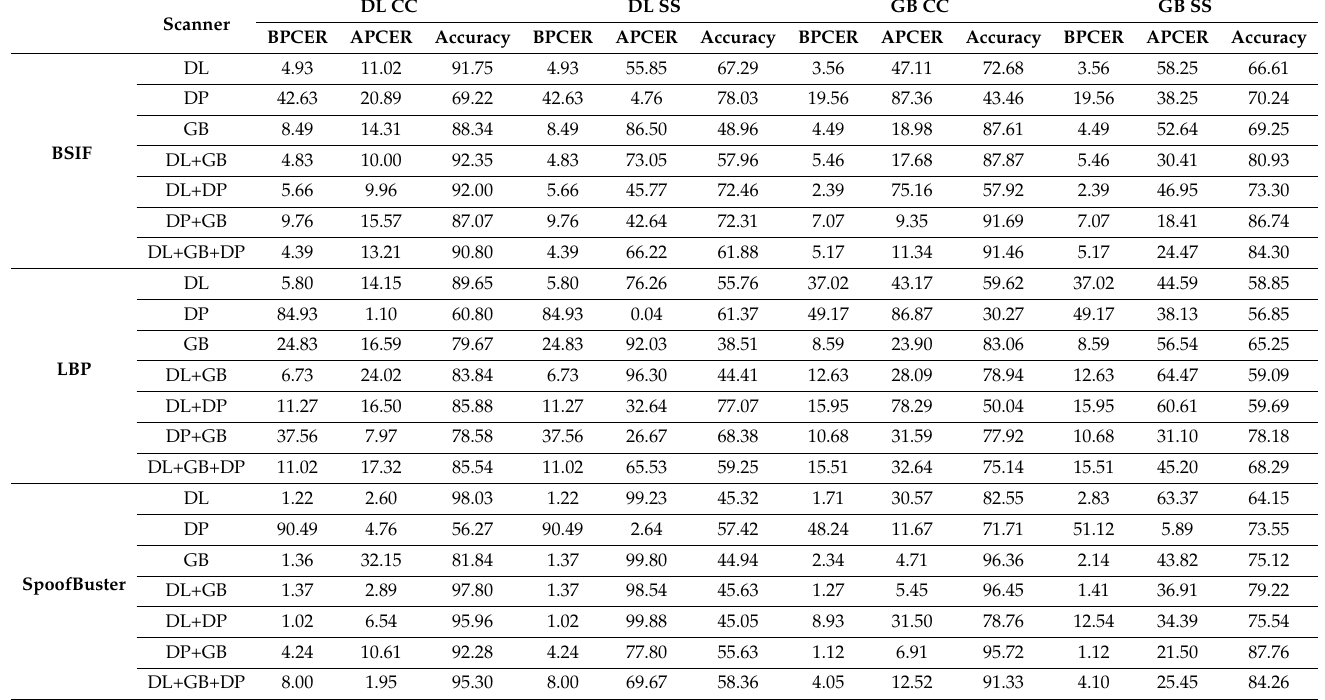
Table 8. Results in terms of accuracy, BPCER, and APCER with a threshold at 0.5 of BSIF, LBP, and SpoofBuster PADs with different single-sensor and multi-sensor training techniques for LivDet 2021